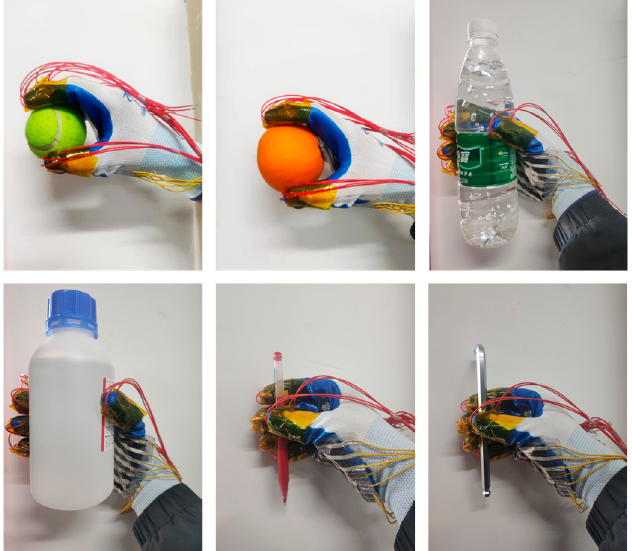
Figure 13. The process of grasping six objects (baseball, orange, mineral water, anhydrous ethanol bottle, pen, and hexagon bar).